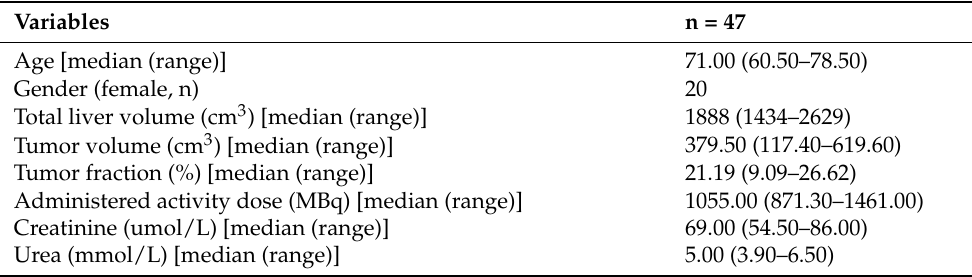
Table 1. Baseline characteristics and standard laboratory parameter. Median value with 75% per- centile is given. Abbreviations: INR, international normalized ration; PTT, partial thromboplas- tin